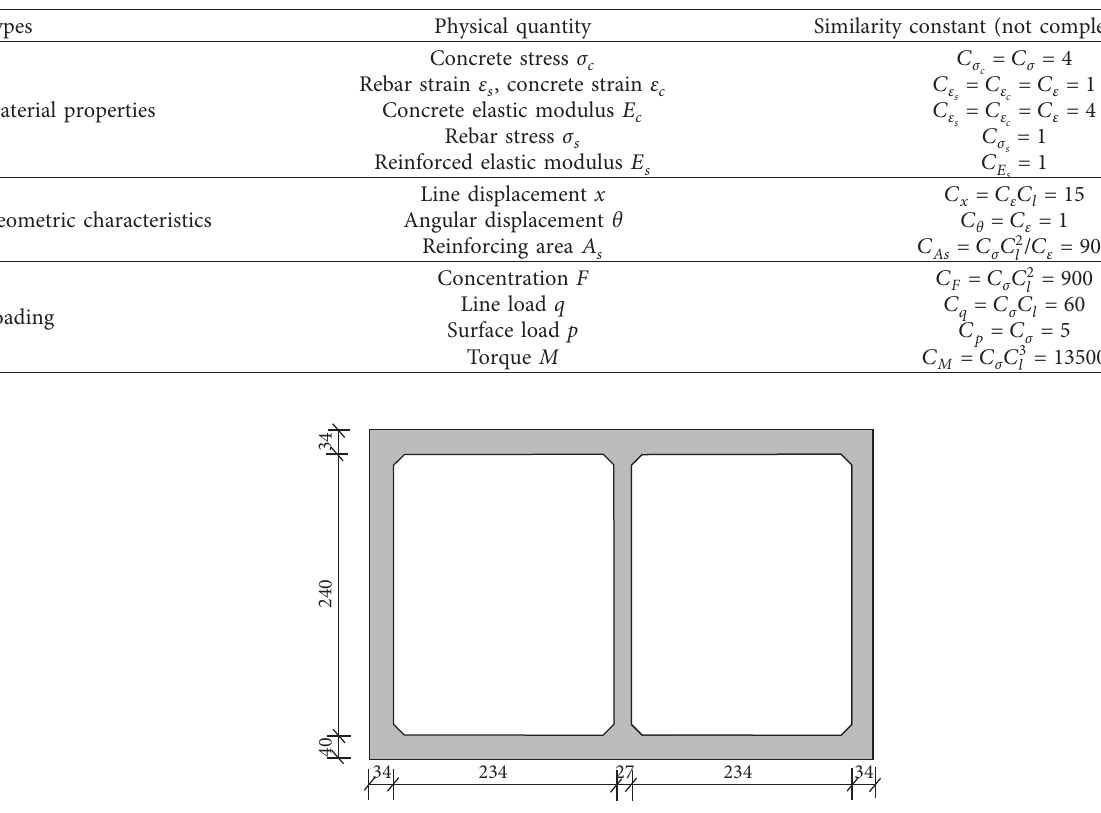
Figure 3: Model box. (a) Test model box picture. (b) Picture of self-locking jack. (c) Test model box schematic. Table 1: Similarity ratio of model test.